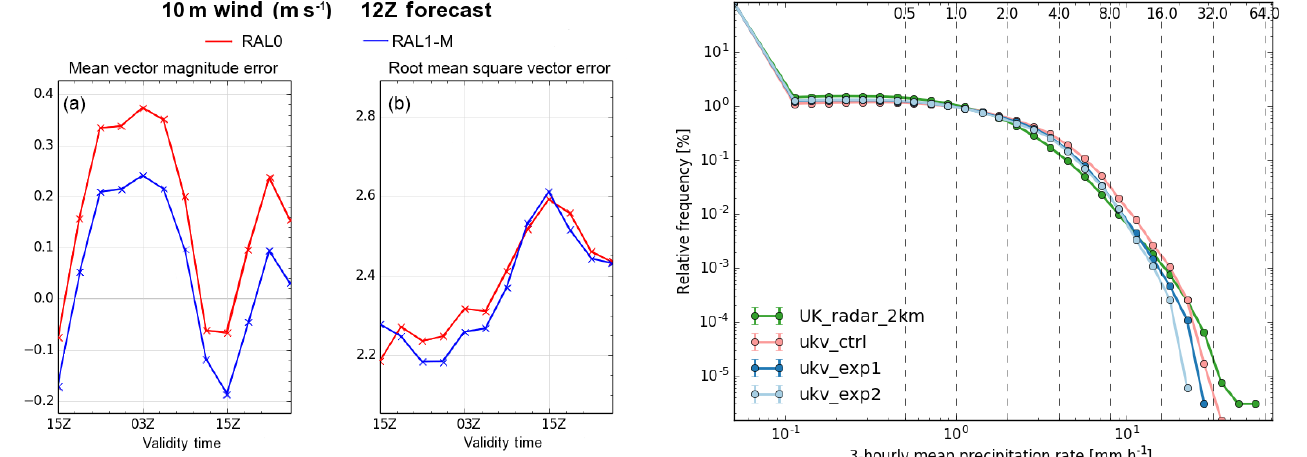
Figure 9. Case studies: relative frequency of 3-hourly precipitation rate. RAL0 (red), RAL1-M (dark blue), RAL1-T (light blue) and 2km UK radar (dark